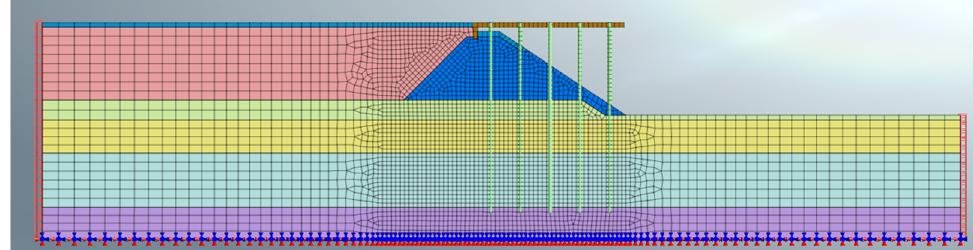
Figure 2. The numerical model.